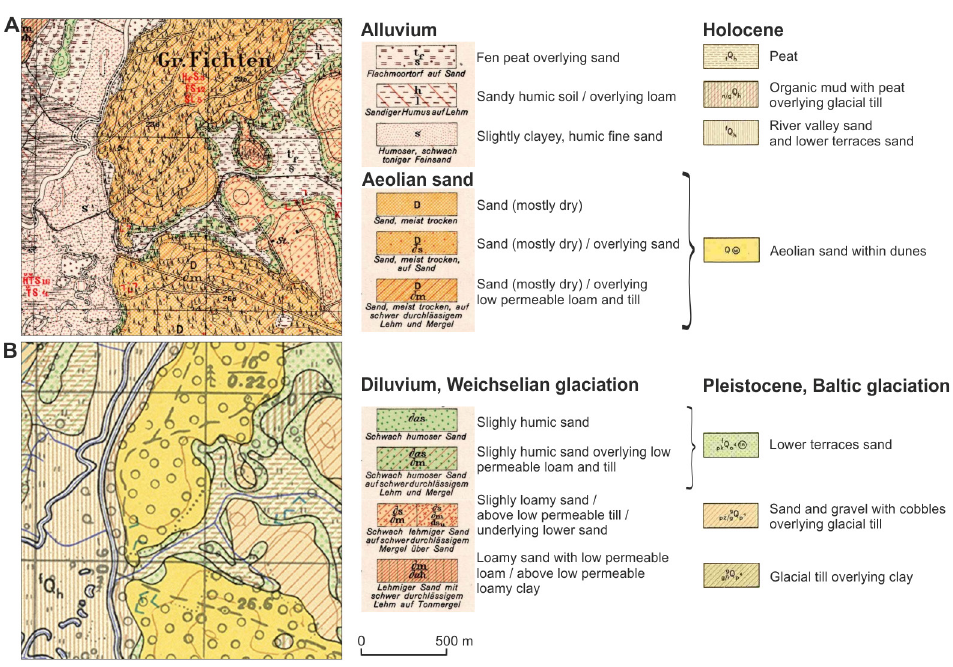
Fig. 3. Parts of geological map, Białogard sheet: A – Geologische Karte des Deutschen Reiches – Belgard at the scale of 1:25,000 (reduced to 1:50,000), B – Szczegółowa mapa geologiczna Polski (Detailed Geological Map of Poland) at the scale of